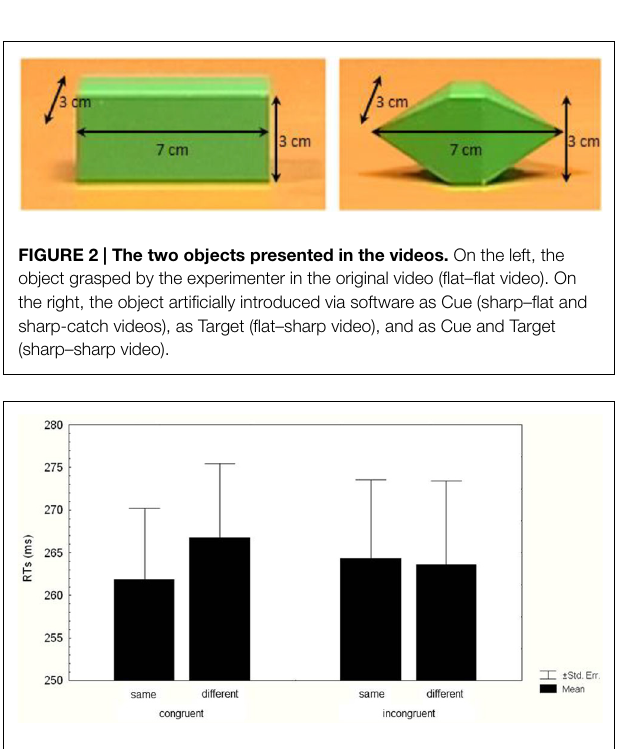
FIGURE 3 | Mean reaction times (RTs) of responses. Data for valid and invalid trials when the kinematics of the agent was suitable (congruent kinematics) and when it was not suitable (incongruent kinematics) to grasp the cued target are shown. Thin lines above histograms indicate standard error of the mean. Ordinates are in milliseconds.